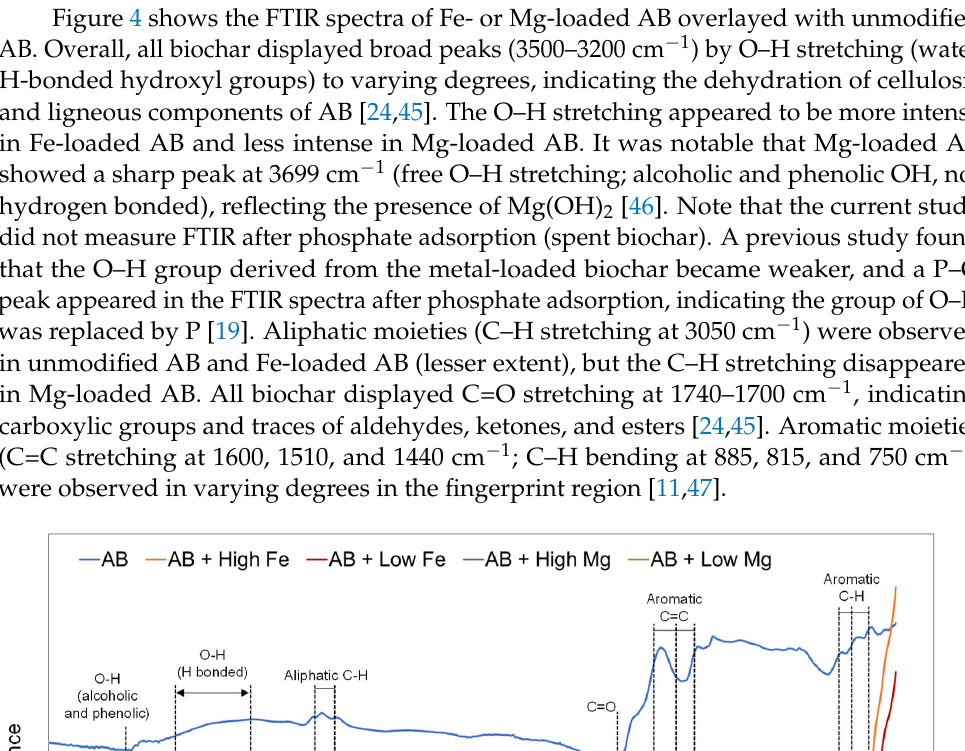
Figure 3. SEM images of avocado seed biochar (AB): ( a ) unmodified AB, ( b ) AB + High Fe, ( c ) AB + Low Fe, ( d ) AB + High Mg, and ( e ) AB + Low Mg.